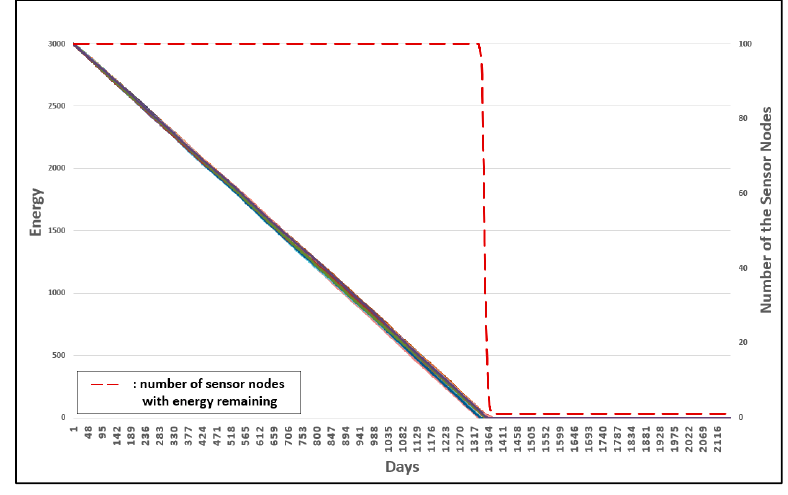
Figure 20. Energy consumption of 3-D GM-MAC without fixed sensor nodes.